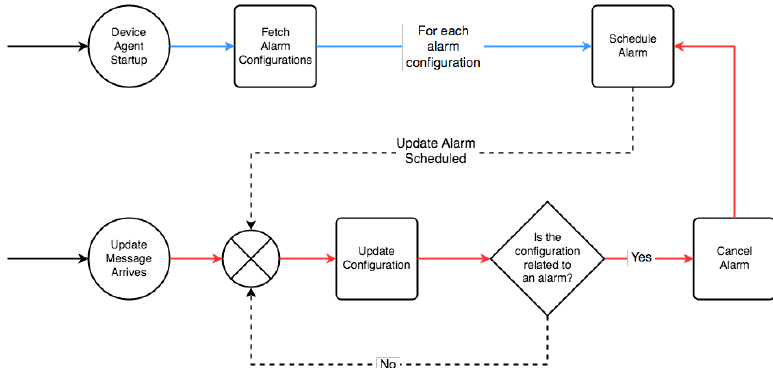
Figure 6. Update management